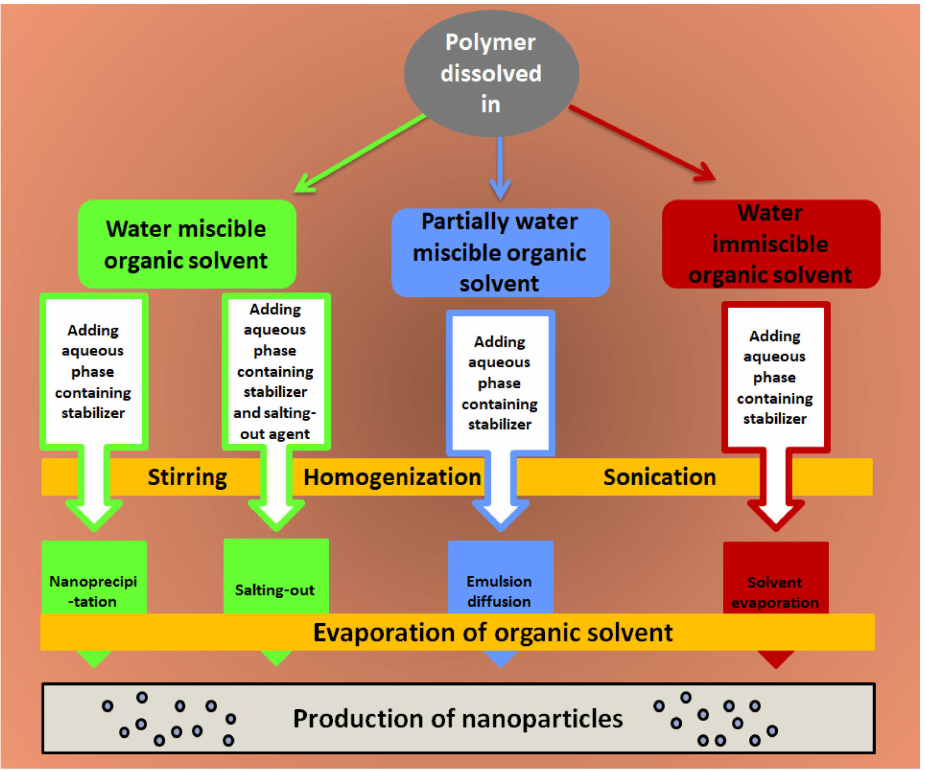
Figure 5. Schematic representation of frequently used techniques used to fabricate synthetic-based polymeric